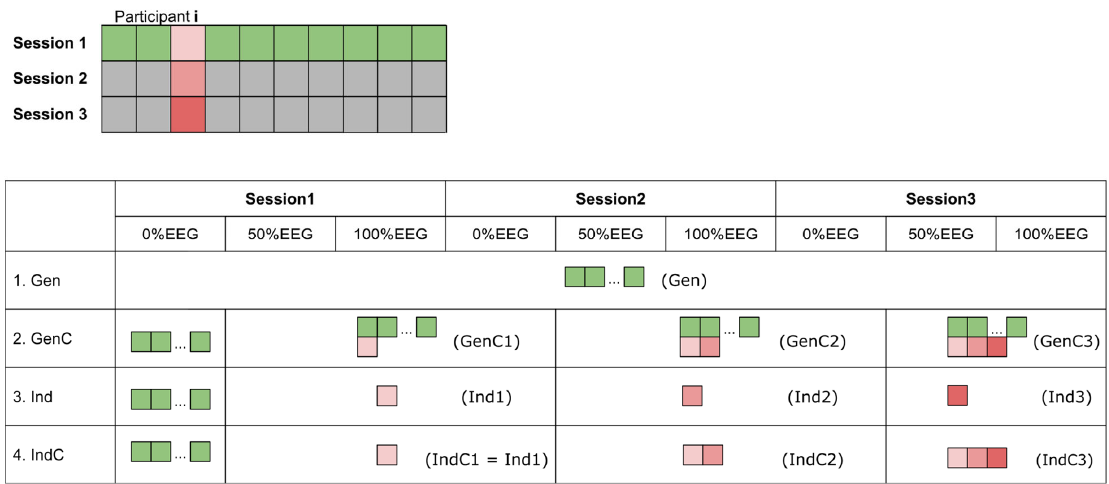
Figure 1. Di ff erent update strategies of 4 di ff erent use cases: generalized model (Gen), cumulative generalized model (GenC), individual model (Ind), and cumulative individual model (IndC). The blocks represent data included in the training data pool for each measurement block. The green blocks visualize the 0% EEG data from session 1 of every participant except the corresponding par- ticipant, represented by the red blocks, where the intensity of the red block represents the corre- sponding session. The text in parentheses represents the term used to refer to the model with dif- ferent training data. The su ffi x C stands for the cumulative model, while the su ffi x numbers indicate the session where the 0% EEG data are included in the training dataset.